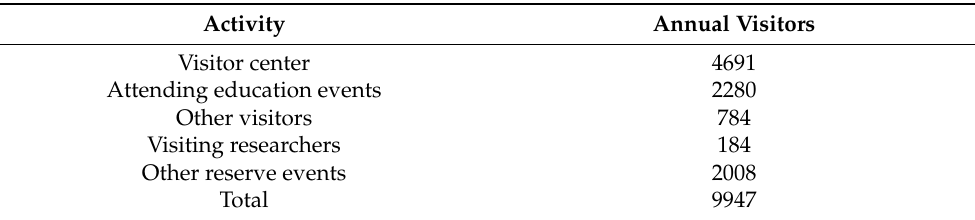
Table 6. Annual visitors to the South Slough Reserve by activity type.